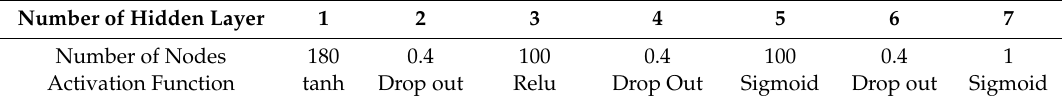
Table 7. The structure of the DNN.